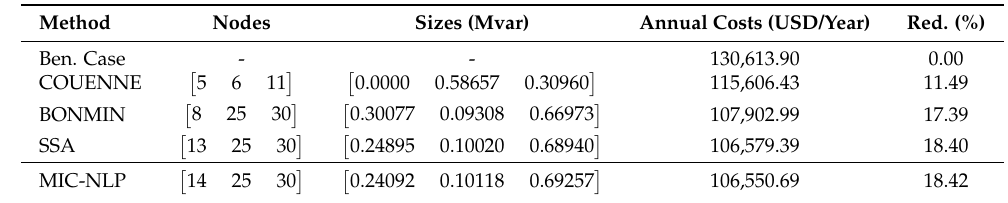
Table 6. Optimal solutions reached by the comparison and proposed optimization methods with variable reactive power injection in a radial grid